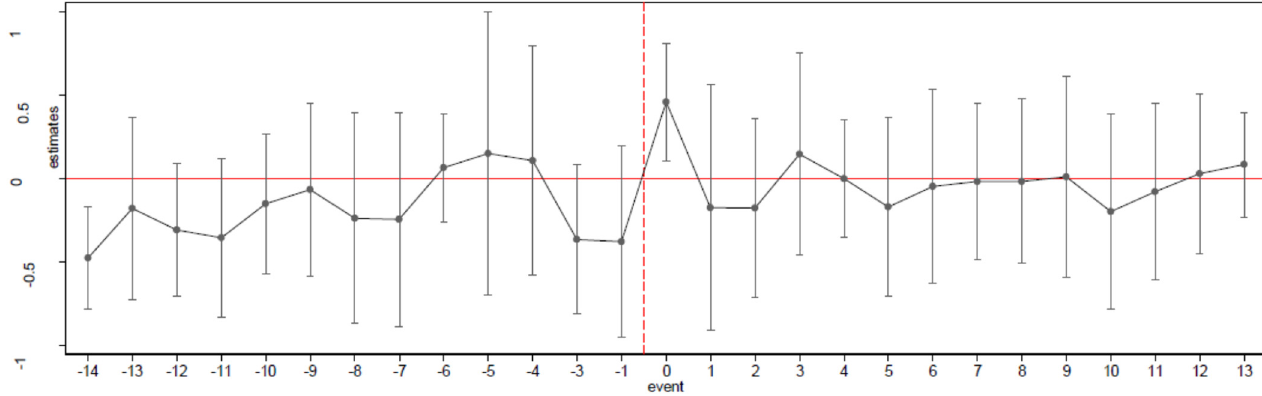
Figure 8. Parallel Trends Analysis—Event Studies on Loans Granted—Fishing Sector.